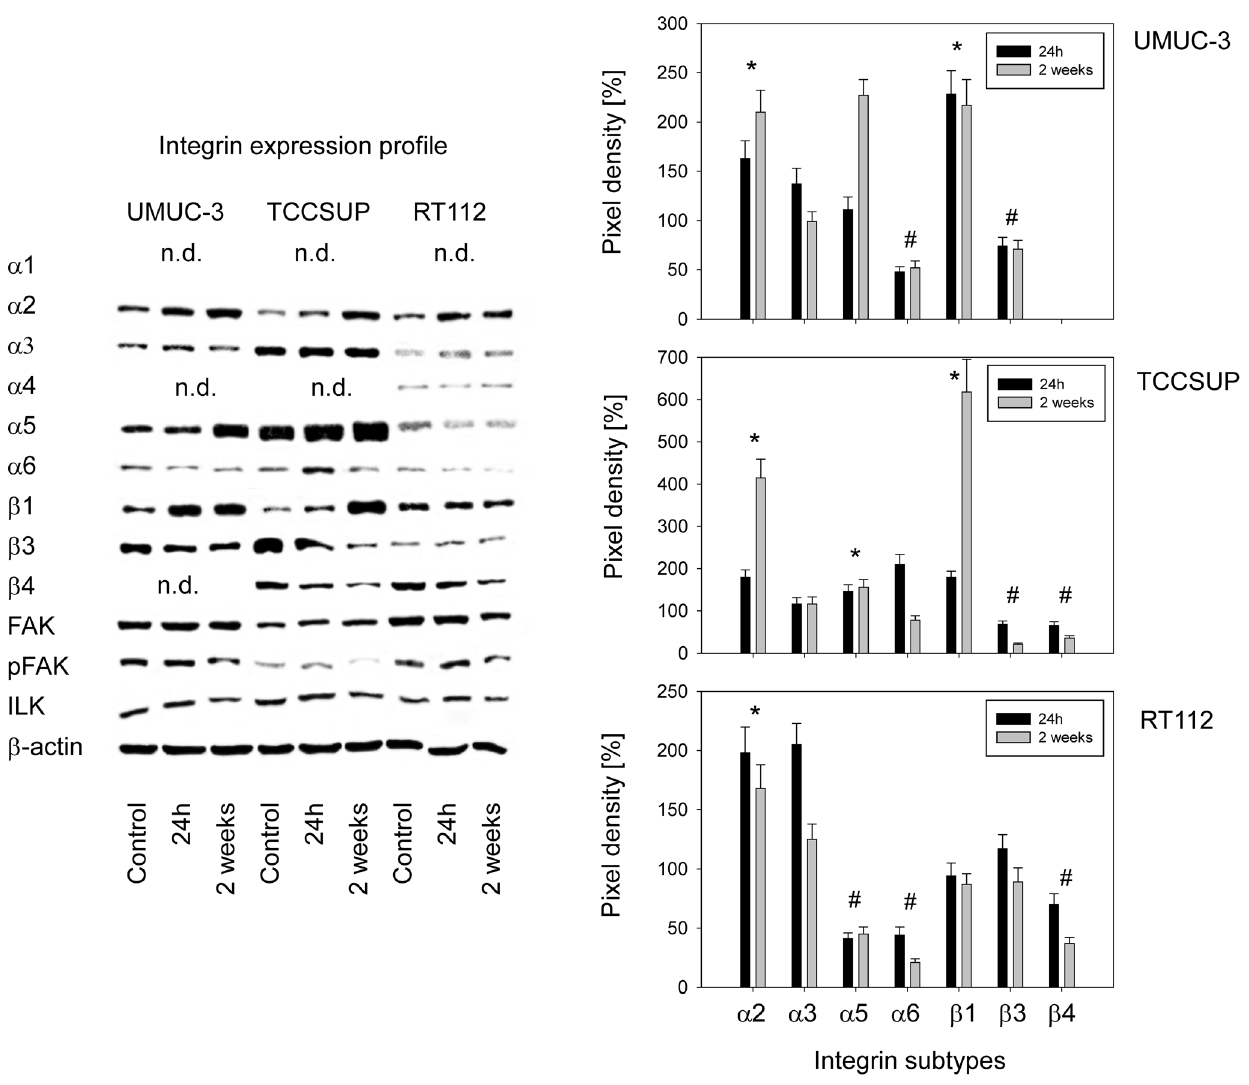
Figure 7. Intracellular integrin protein content of UMUC-3, TCCSUP and RT112 bladder cancer cells exposed to amygdalin for 24 h or 2 weeks. Controls remained untreated. b -actin served as the internal control. The figure shows one representative from three separate experiments. n.d. indicates ‘‘not detectable’’. Quantification of integrin subtype expression is depicted on the right. Pixel density is given in percentage compared to controls not treated with amygdalin. *indicates significant increase after both 24 h and 2 weeks amygdalin treatment, # indicates significant decrease after both 24 h and 2 weeks amygdalin treatment, compared to controls.